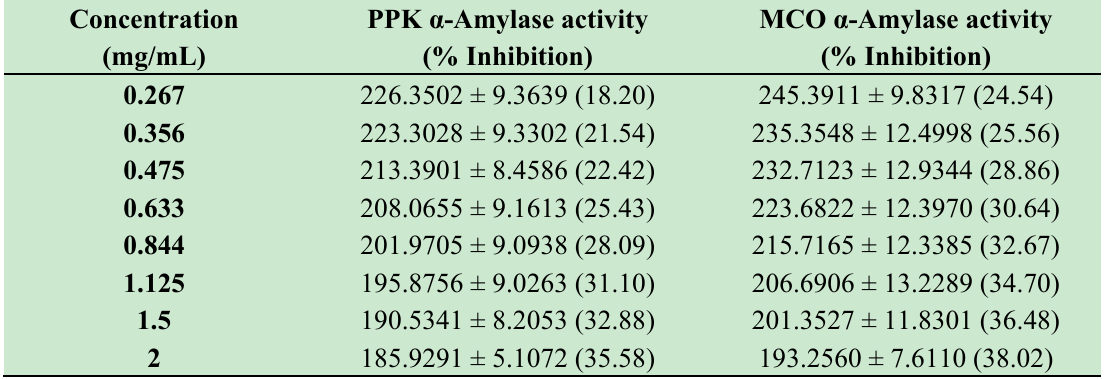
Table 5. Effect of polypeptide-k and oil from Momordica charantia on α -amylase activity.